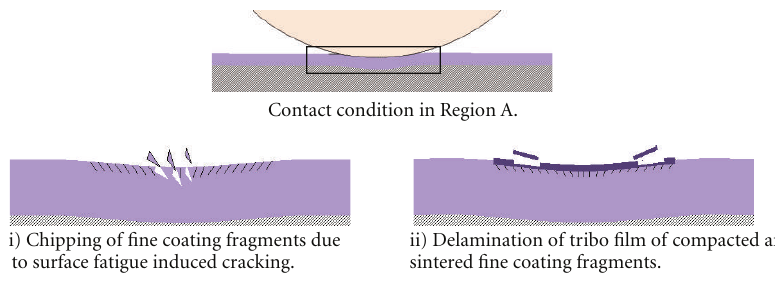
Contact condition in Region A.